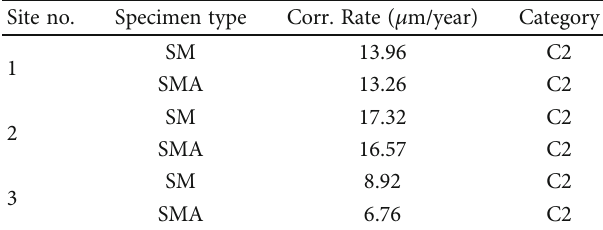
Table 5: Corrosion rate values and atmosphere aggressiveness. Site